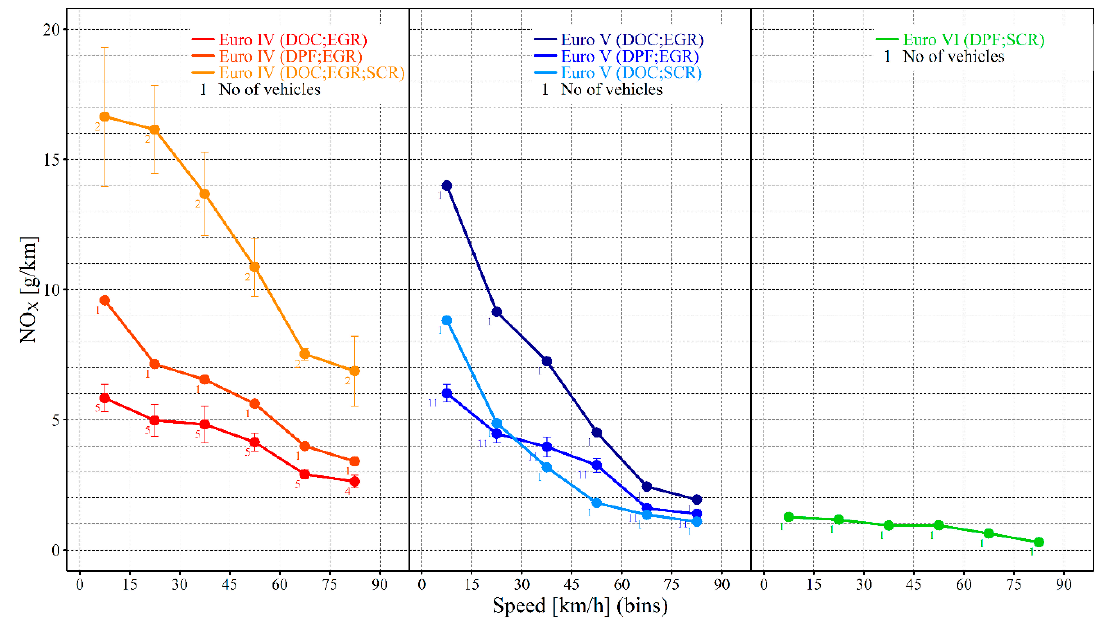
Figure 3. Sample mean and ± one standard error limits of the distance-based NO x emission levels over speed (500 m driving sequences). Numbers next to each dot correspond to number of vehicles that have been averaged.